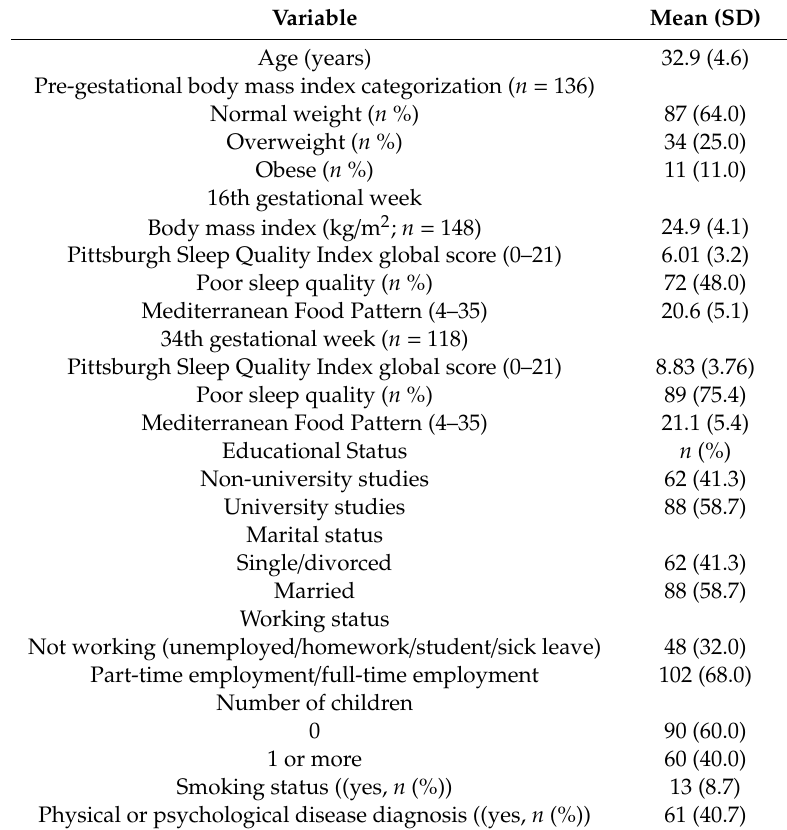
Table 1. Descriptive characteristics of the study participants ( n = 150).